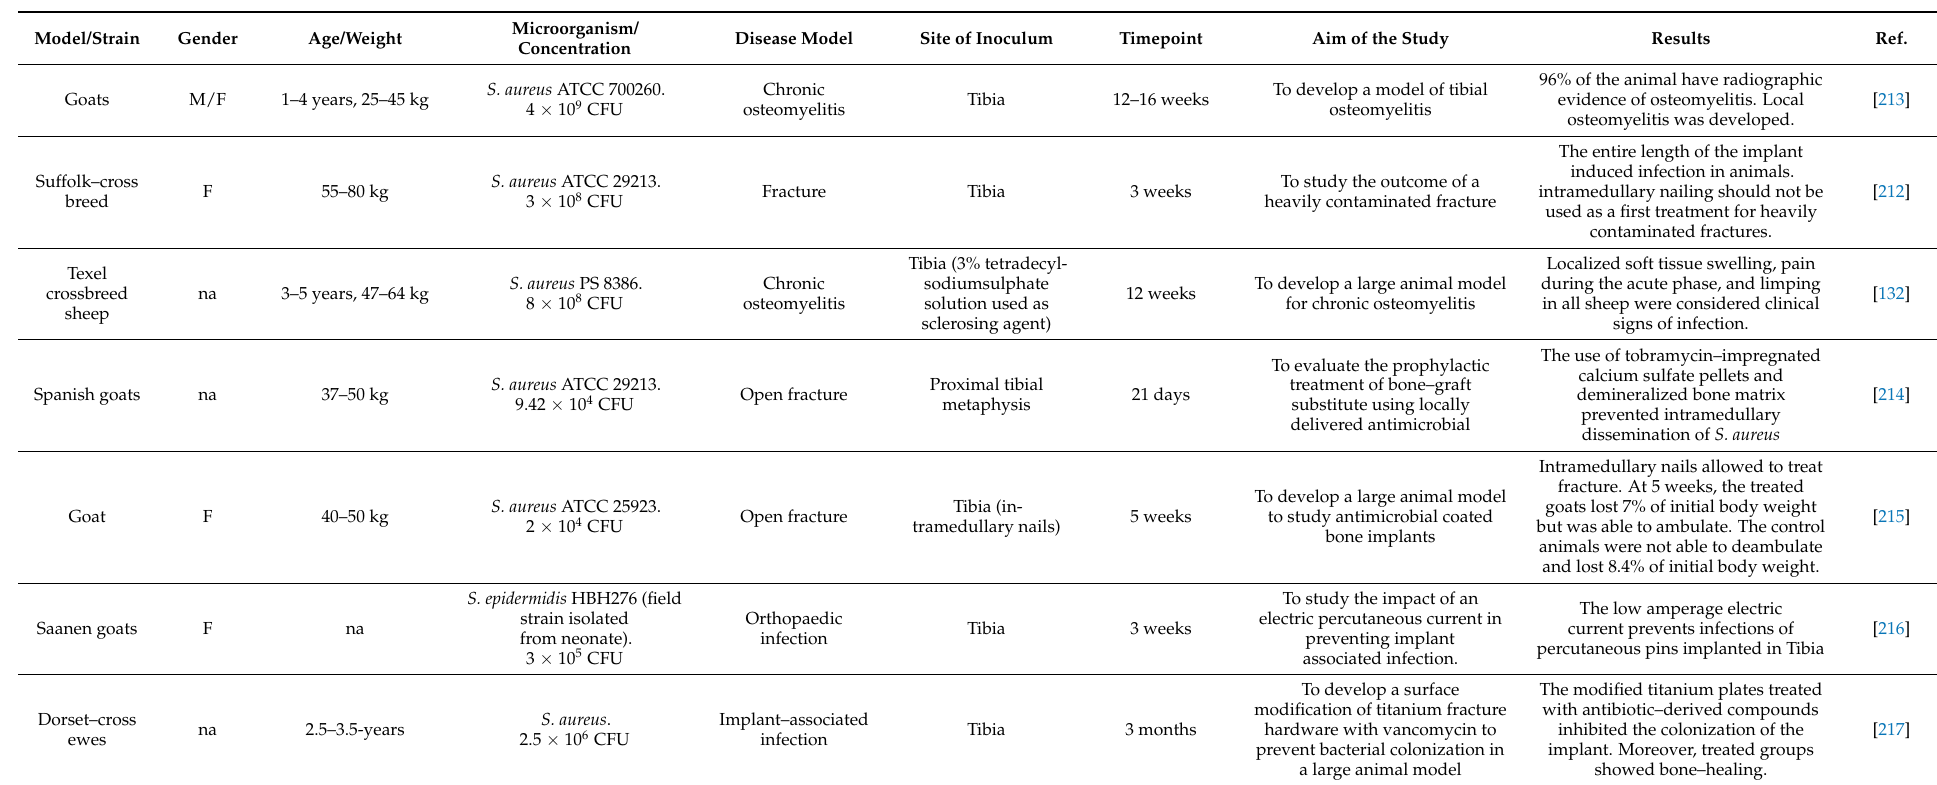
Table 6. Sheep and Goat models of orthopedic